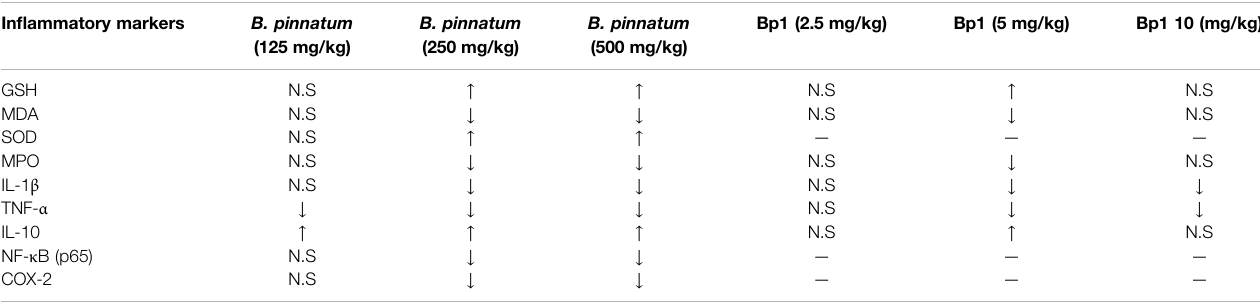
TABLE 5 | Modulation of antioxidant defense system and in fl ammatory markers. In fl ammatory markers